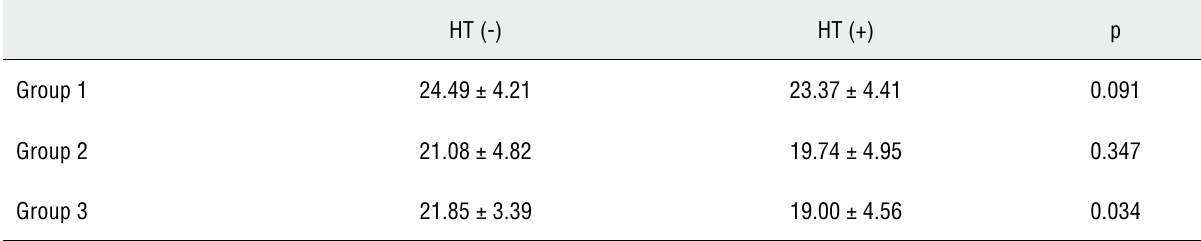
Table 6 - The relationship between IIEF scores and number of occluded vessels in terms of hypertension.